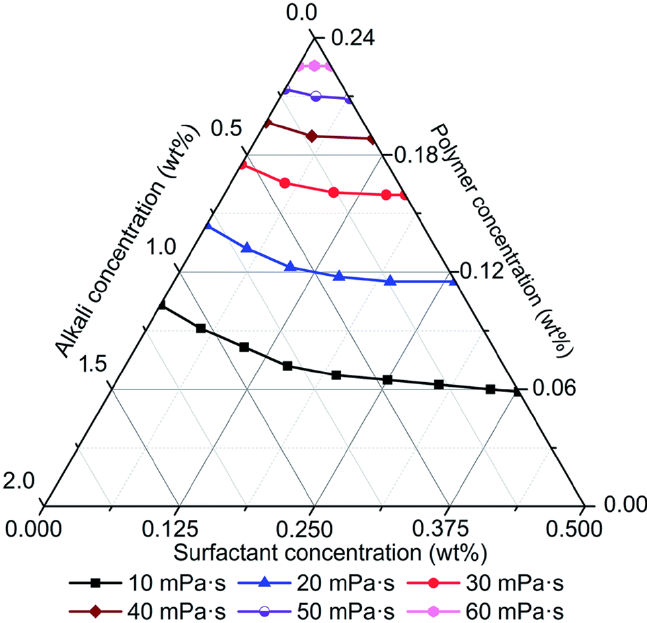
Figure 1. Effects of ASP components on viscosity.